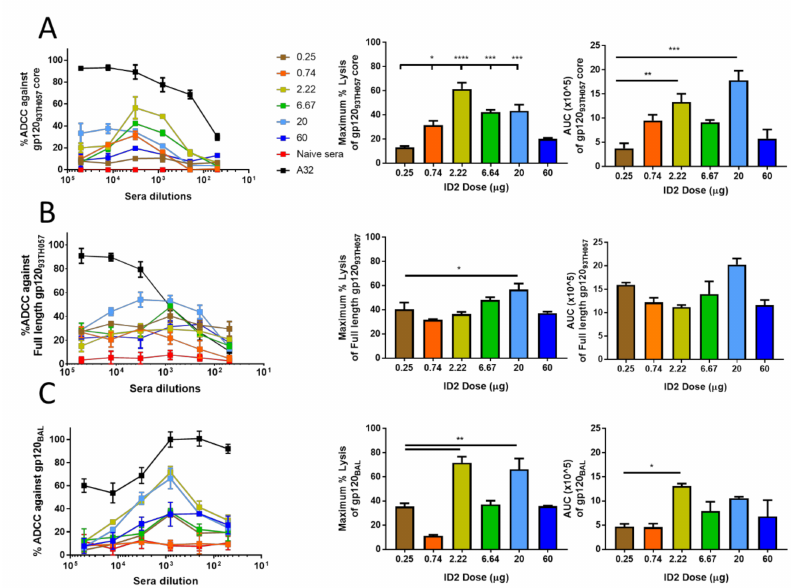
Figure 2. RFADCC capabilities of sera from ID2 immunized mice. The RFADCC potential of pooled sera from ID2 immunized mice was assayed against a number of targets. ( A ) RFADCC against gp120 93TH057 core coated ( B ) full-length gp120 93TH057 and ( C ) gp120 BaL coated EGFP-CEN-NKR-CCR5SNAP target cells. The left panels show the % RFADCC over a number of sera of A32 positive control antibody concentrations over a 4-fold dilution. The middle panels display the maximum % lysis against each target and the right panels display the overall area under curve (AUC) for each immunization group. Sera were pooled for each dosing group and analyzed 2 weeks following the final immunization. n = 6 mice for each group, pooled sera were evaluated in triplicate and displayed as mean ± SEM. Max % lysis and AUC were analyzed for statistical significance using a one-way ANOVA with Tukey’s test for multiple comparisons. Significance values are indicated as * p < 0.05, ** p < 0.01, *** p < 0.001, and **** p <